Question: Produce a descriptive caption suitable for publication.
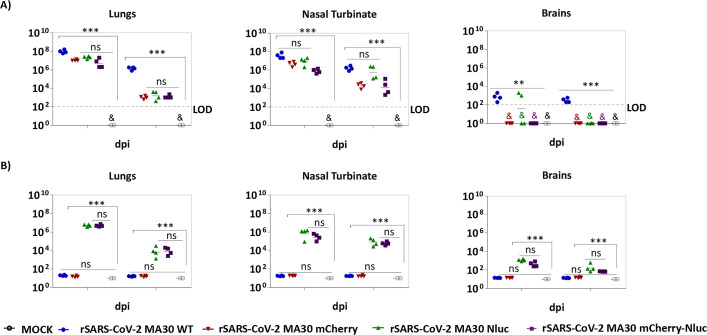
Answer: Viral titers and Nluc activity in tissue homogenates of C57BL/6 mice infected with reporter-expressing rSARS-CoV-2 MA30: Viral titers ( A ) and Nluc activity ( B ) in the lung (left), nasal turbinate (middle), and brain (right) tissue homogenates of 22-week-old C57BL/6 mice mock-infected or infected i.n. with 10 5 PFU/mouse of rSARS-CoV-2 MA30 WT, rSARS-CoV-2 MA30 mCherry, rSARS-CoV-2 MA30 Nluc, and rSARS-CoV-2 MA30 mCherry-Nluc at 2 ( n = 4/group) and 4 ( n = 4/group) dpi were determined by standard plaque assay and microplate reader, respectively. The results are the mean values and SD. LOD, limit of detection. **P < 0.01; *** P < 0.001; ns, not significant; (&) nd, not detected.